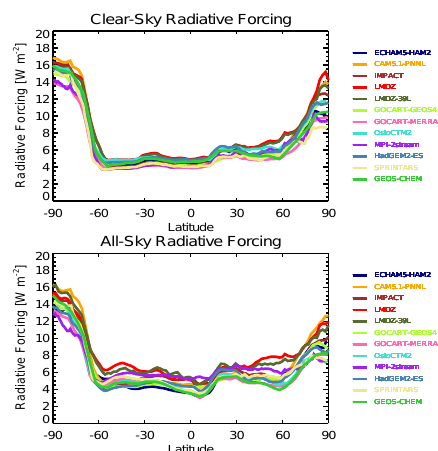
Fig. A9. Annual zonal-mean short-wave difference between all-sky and clear-sky top-of-atmosphere radiative forcing between experiments with AOD=0.2 and AOD=0.0 and (a) SSA=1.0, (b) SSA=0.8 distributed over the lowest two kilometers, holding ANG=1.0